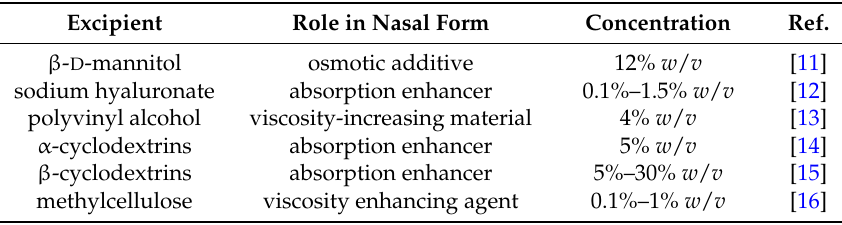
Table 1. Important additives in nasal formulations.